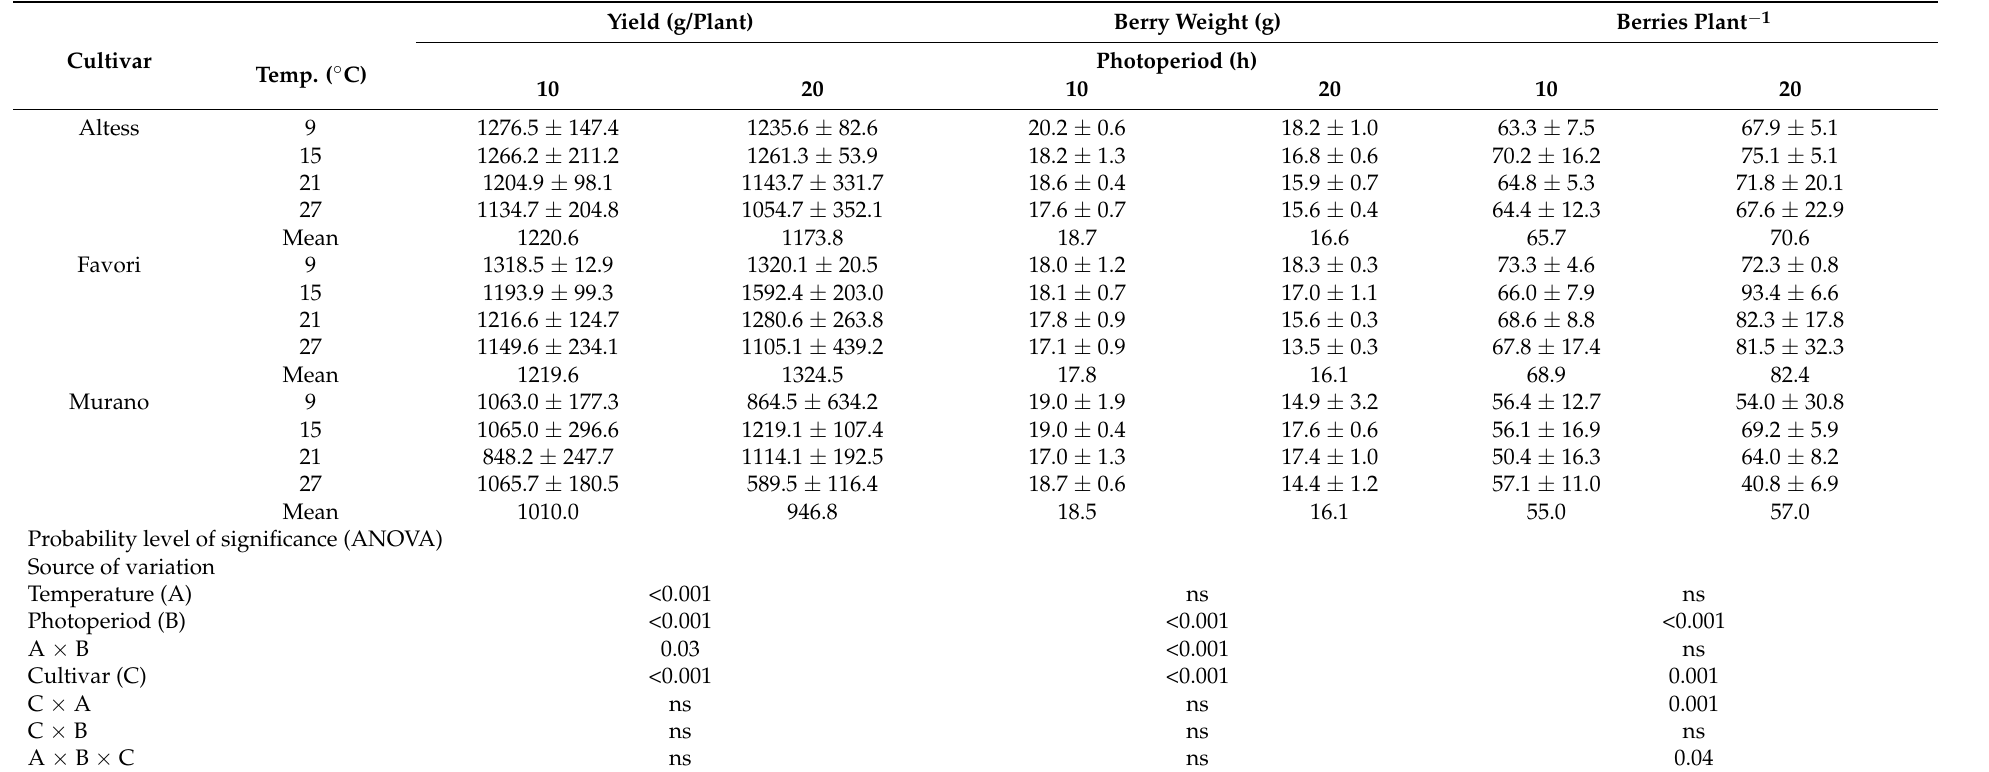
Table 1. Effects of preconditioning temperature and photoperiod on total berry yield and yield components of three EB strawberry cultivars when cropped on a tabletop system in high plastic tunnels in the year after treatment. Data are means ± SD of three replications, each with four plants of each cultivar. Plants were harvested from 8 July to 2 October